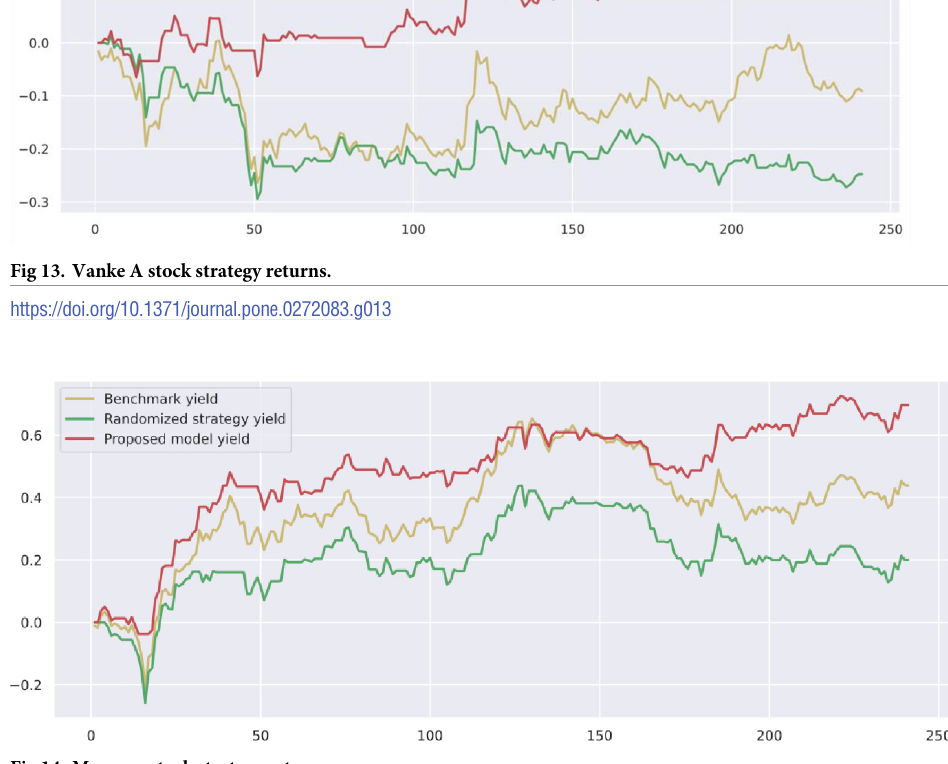
Fig 14. Mu yuan stock strategy